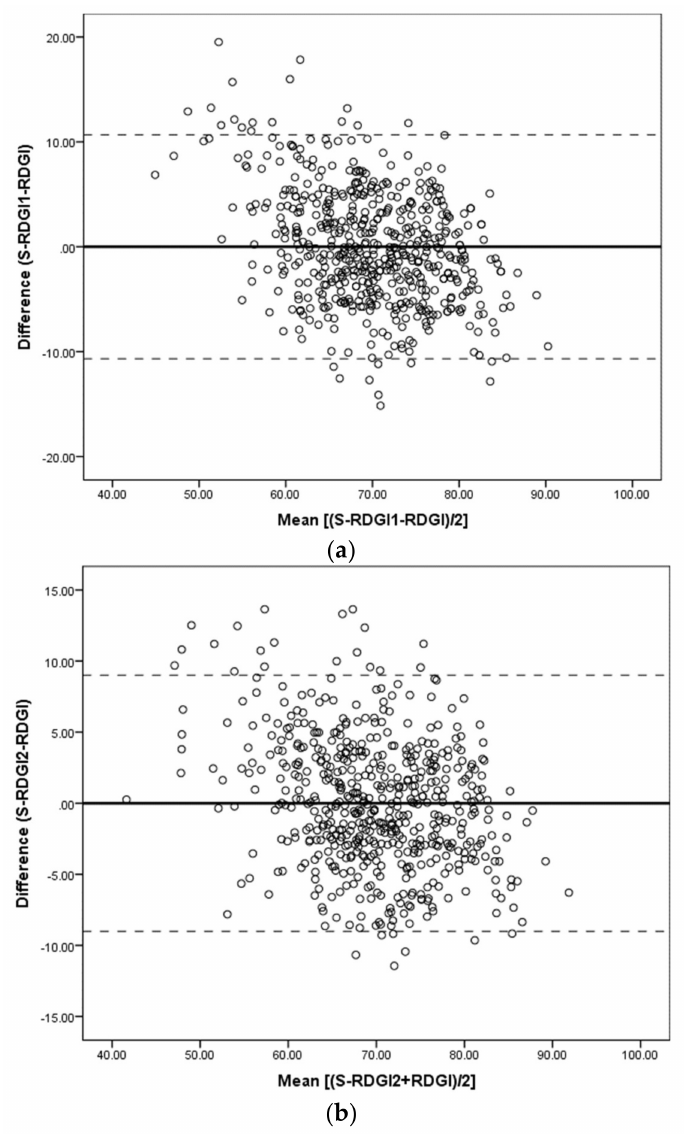
Figure 1. Bland-Altman plot showing agreement between diet quality scores calculated by the RDGI and: ( a ) S-RDGI1; ( b ) S-RDGI2. – Mean difference, – – – 95% limits of agreement